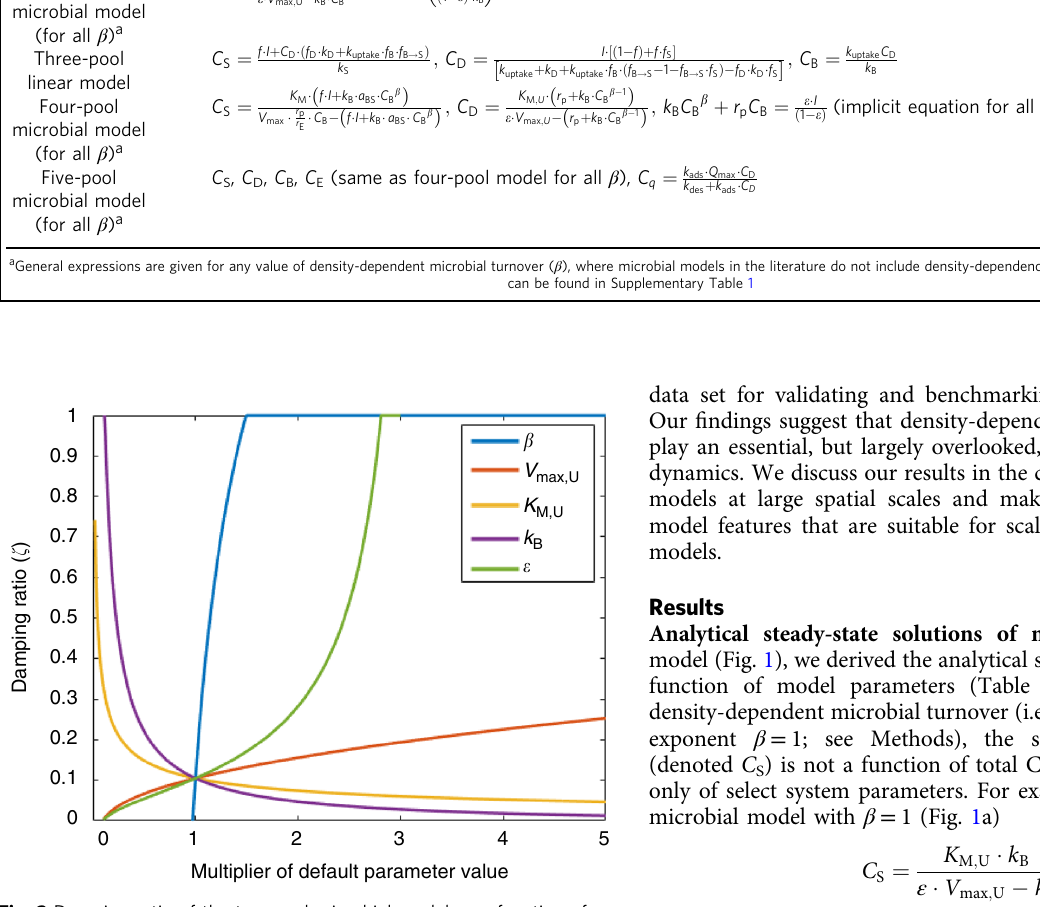
Table 1 Steady-state solutions of the SOC decomposition models Two-pool microbial model